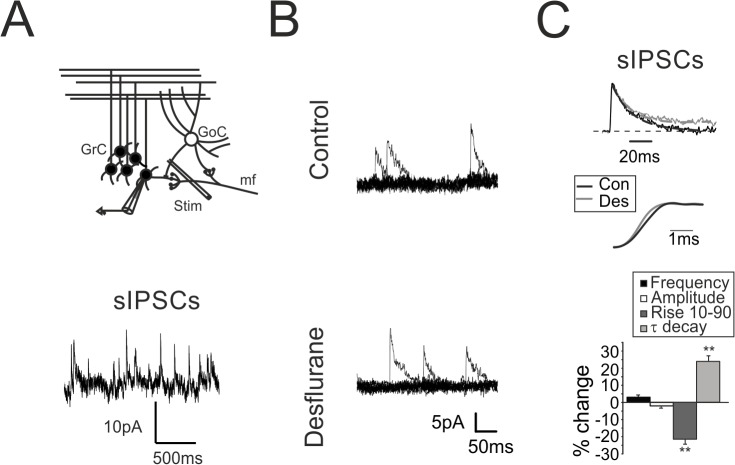
Modulation of spontaneous GABAergic inhibition by desflurane.
A. Scheme of the granular layer microcircuit. The stimulating electrode (stim) is placed in the surrounding of the recorded GrC to evoke action potentials in the GoC axonal plexus. Traces: Spontaneous IPSCs recorded from GrCs voltage clamped at 0 mV reflects the autorhythmic discharge of GoCs. B. sIPSCs recorded from a granule cell before (top) and after (bottom) the application of desflurane. Note that sIPSC frequency and peak amplitude are unchanged. C. Normalized sIPSCs recorded from a GrC before (black) and during (gray) desflurane application. The mono-exponential fitting of the current relaxation reveals significant changes in the decay while the rise time is decreased (middle). Histogram summarizes the effects induced by desflurane on the biophysical properties of spontaneous inhibitory currents (n = 7).